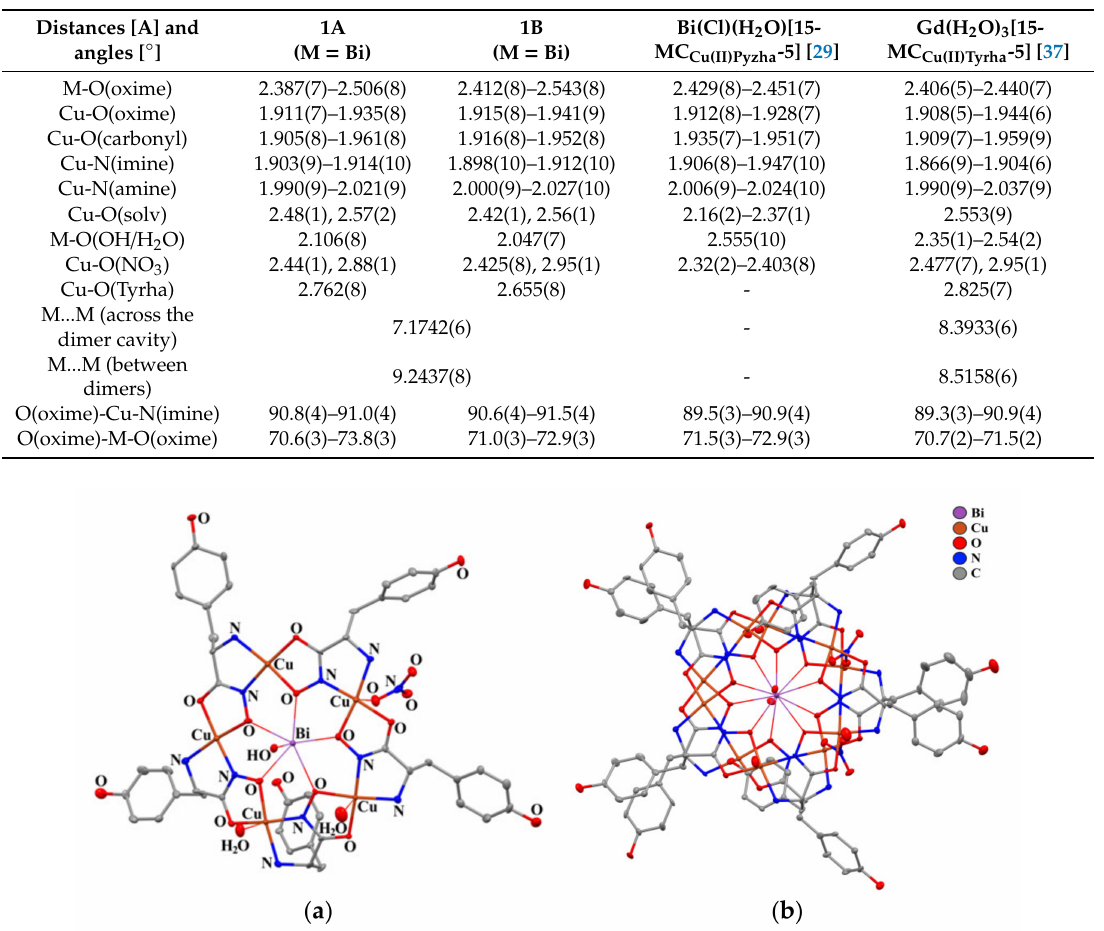
Figure 5. Top views of the structure of complex 1 : ( a ) monomer and ( b ) dimer pair shown looking down the pseudo fivefold axis. The thermal ellipsoids drawn are at the 30% probability level. All hydrogen atoms, uncoordinated NO 3 − and solvate water molecules are omitted for